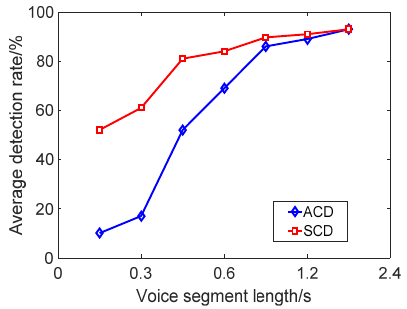
Figure 9. Average detection rate of speech steganography with different duration.